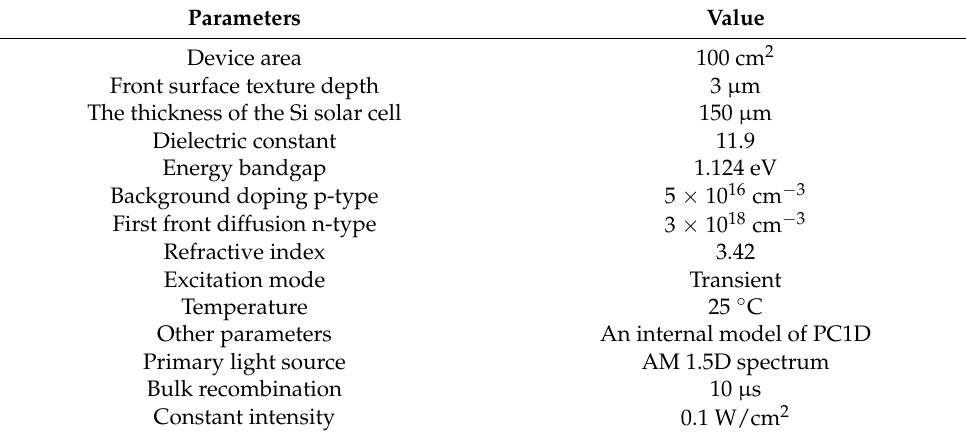
Table 1. Simulation parameters used in PC1D tool for HfO 2 ARC layer-based c-Si solar